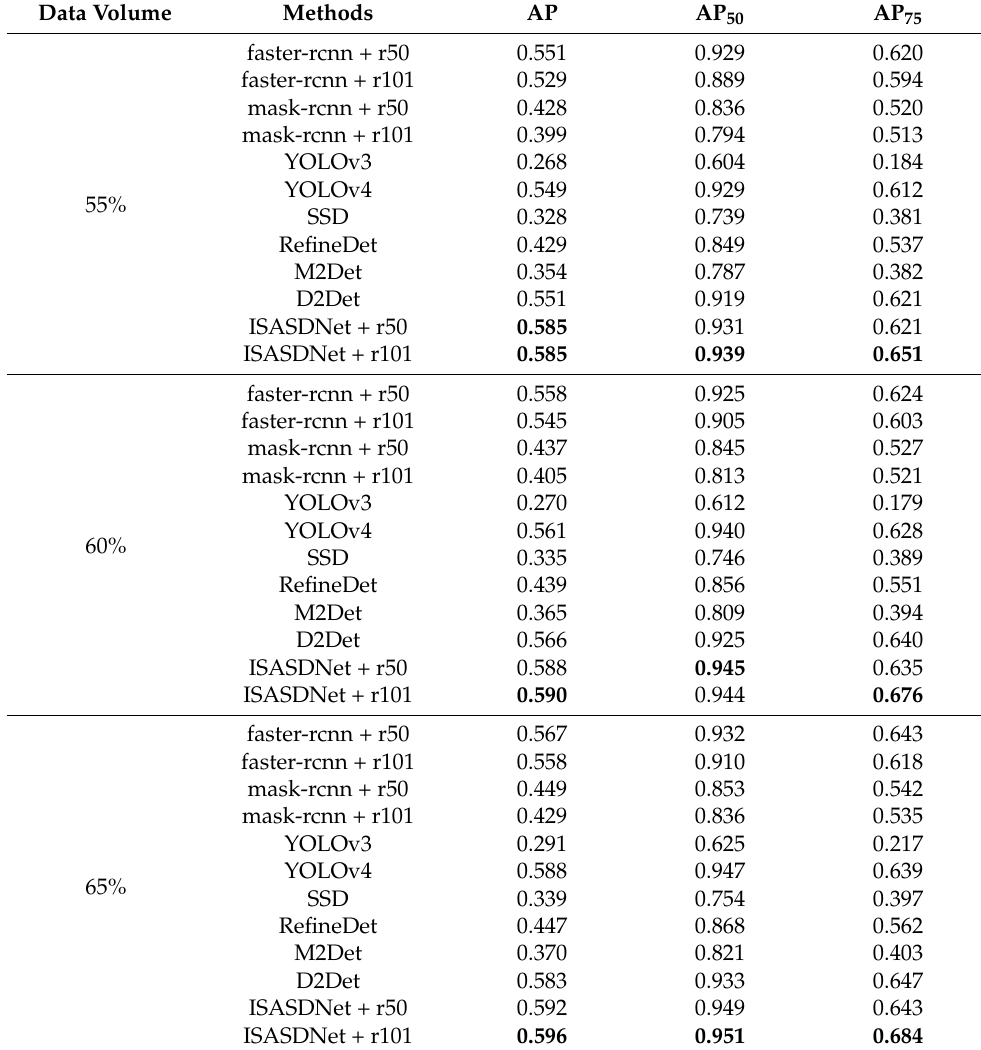
Table 8. AP of methods under different amount of data.